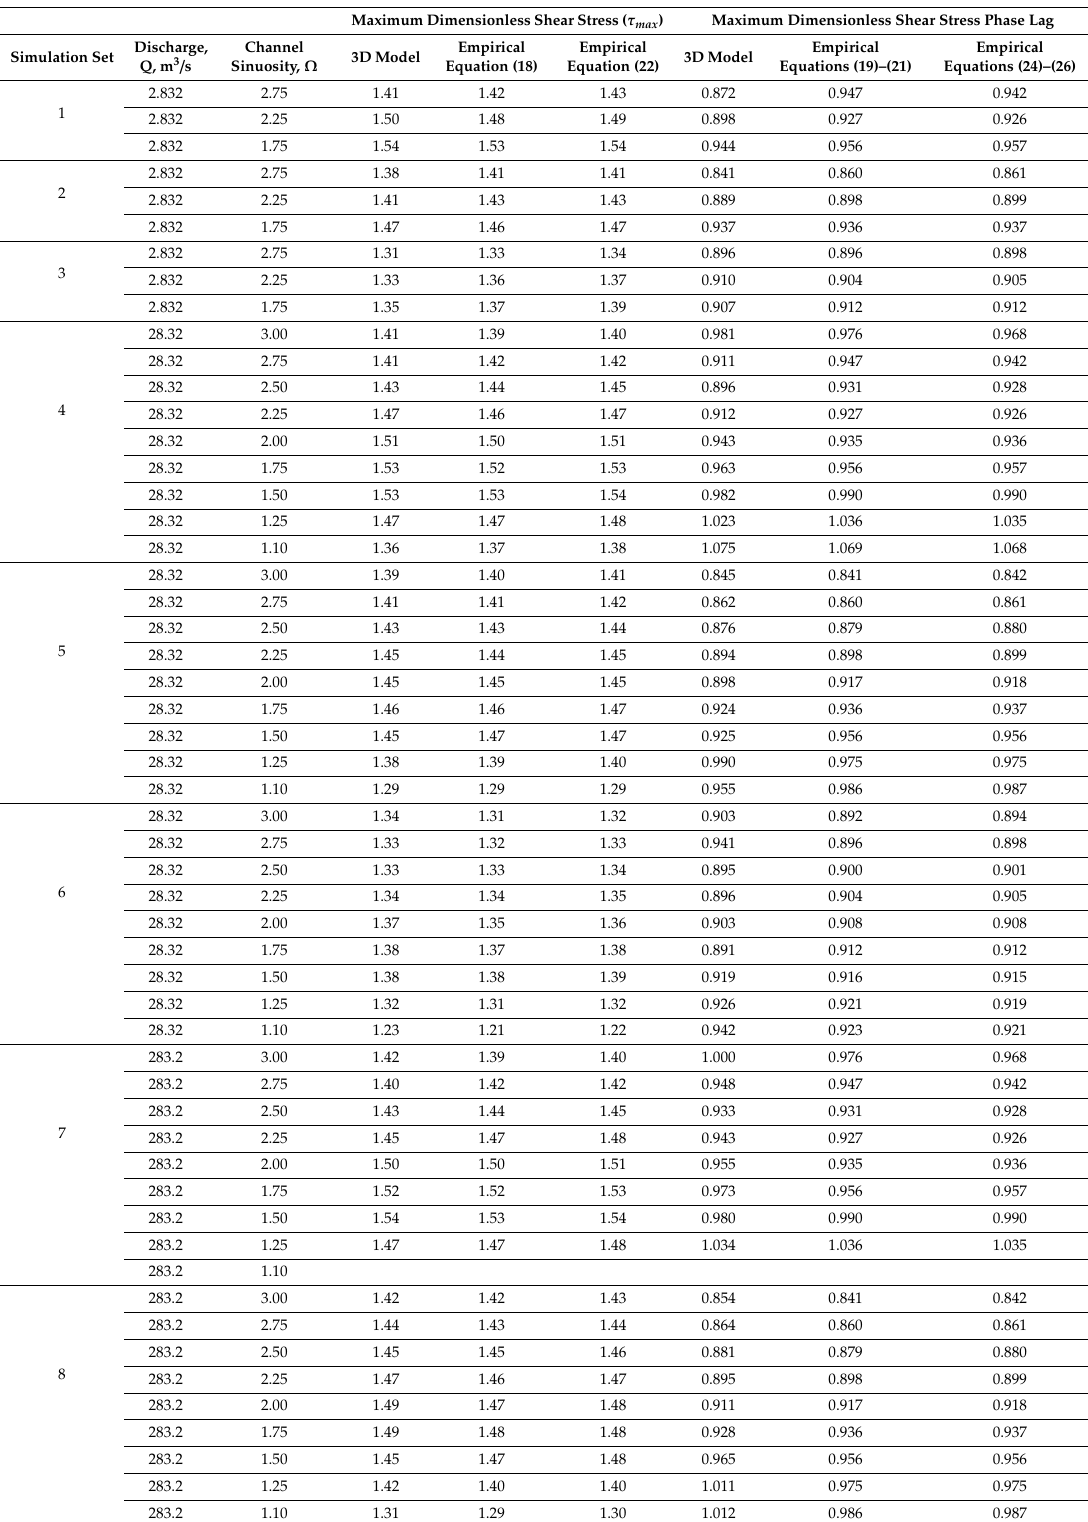
Table A8. Maximum dimensionless shear stress and phase lag from 3D model simulations and empirical